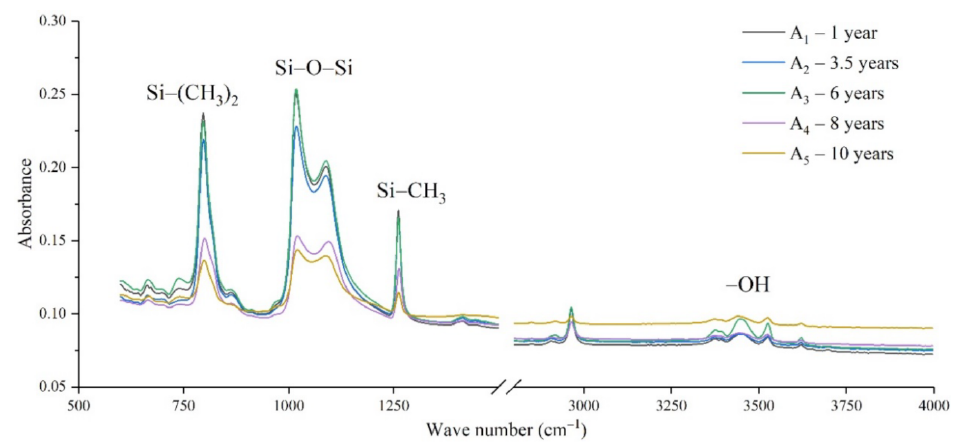
Figure 3. FTIR results of samples from manufacturer